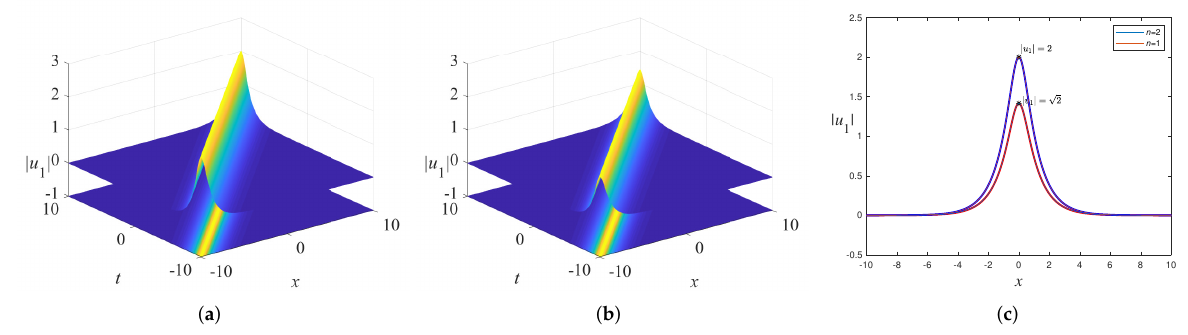
Figure 3. One-soliton solutions | u 1 | to the mHOCLL system: ( a ) n = 1, λ 1 = 0.5 − 0.5i, c 1,1 = c 1,2 = 1; ( b ) n = 2, λ 1 = 0.5 − 0.5i, c 1,1 = c 1,2 = c 1,3 = 1; ( c ) when t = 0, the comparison of the two